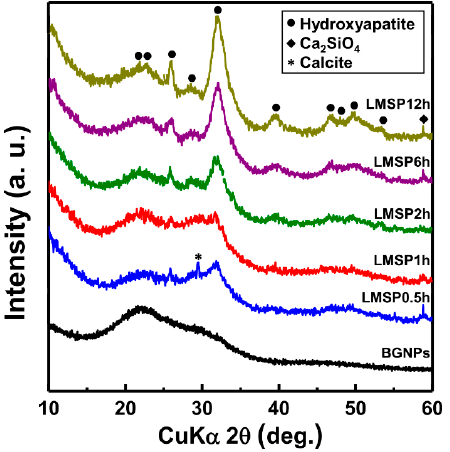
Figure 4. XRD patterns of BGNPs and LMSP samples in order of the sintering times from 0.5 to 12